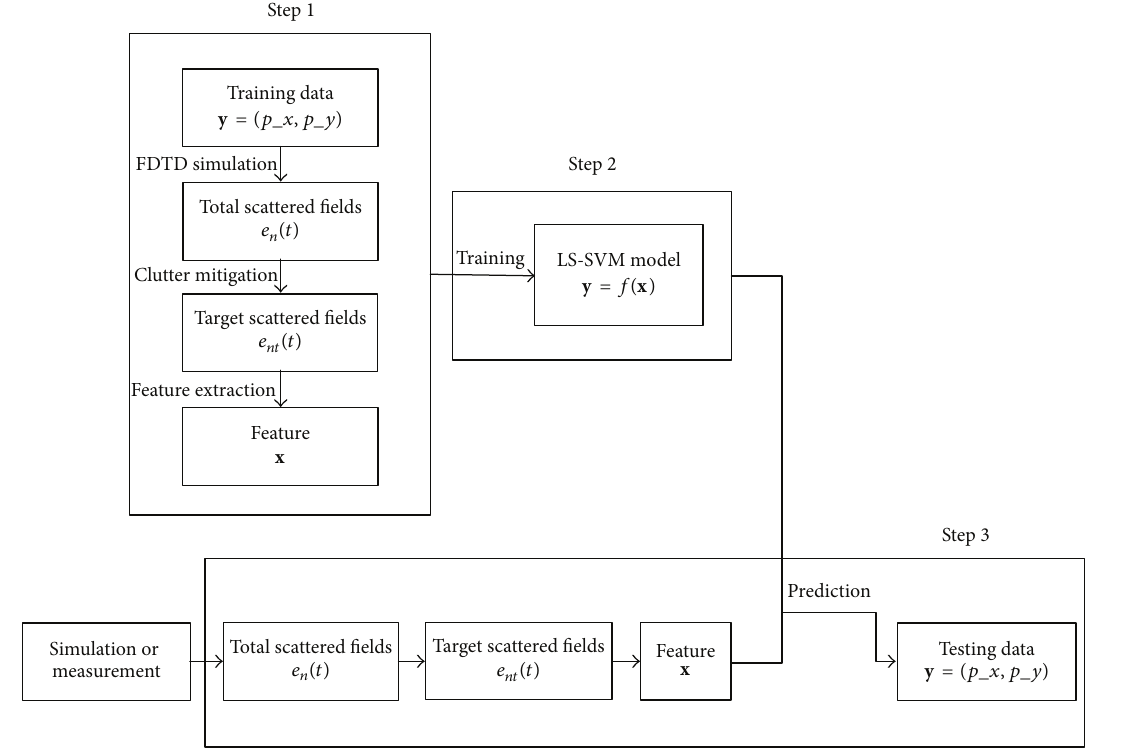
Figure 2: Procedure of the through-wall